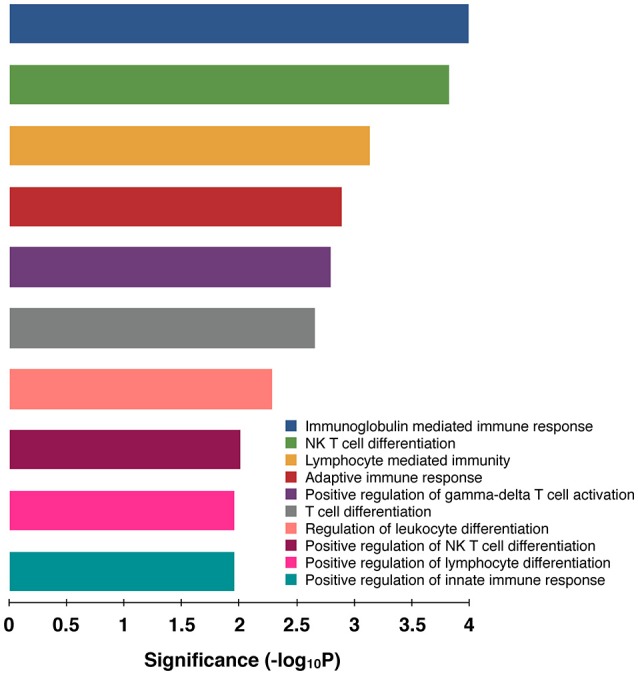
Top 10 Significant (P < 0.05) Immunological processes involved in virulent PPRV goats PBMCs. Color differentiates the immune processes.